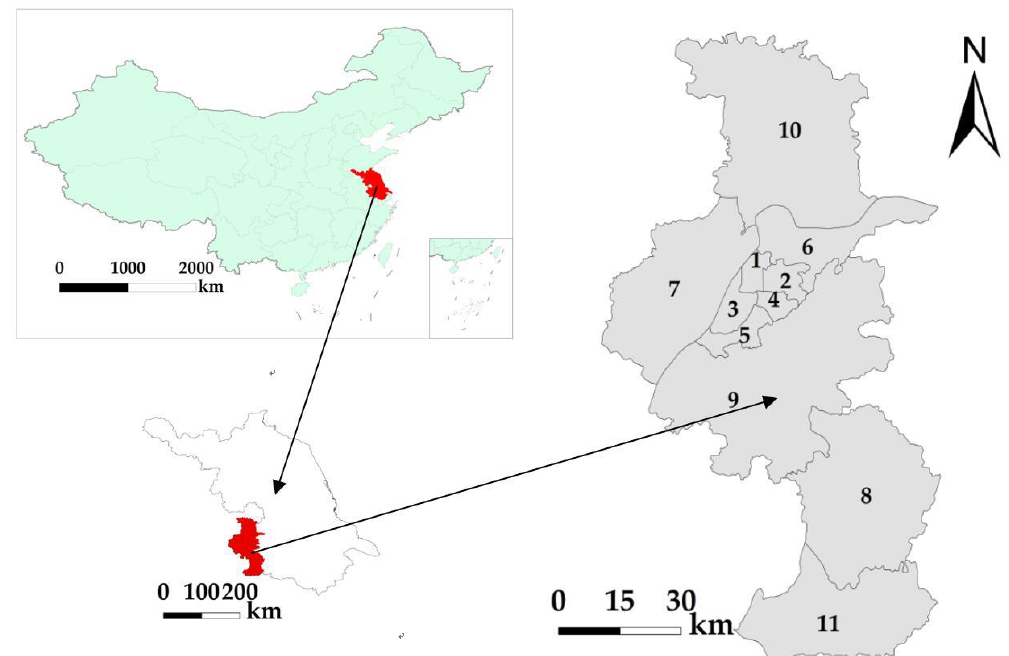
Figure 1. Administrative divisions in Nanjing: ( 1 ) Gulou; ( 2 ) Xuanwu; ( 3 ) Jianye; ( 4 ) Qinhuai; ( 5 ) Yuhuatai; ( 6 ) Qixia; ( 7 ) Pukou; ( 8 ) Lishui; ( 9 ) Jiangning; ( 10 ) Liuhe; ( 11 ) Gaochun.